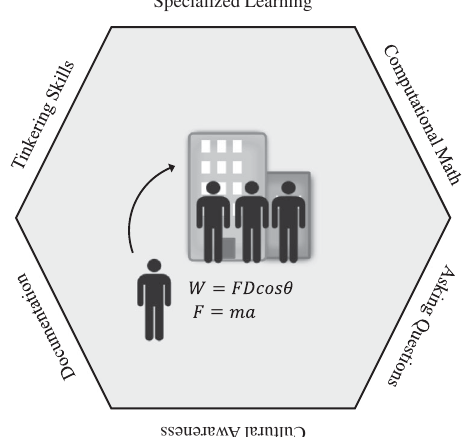
FIG. 1. Factors that influence entry and success in the optics and photonics